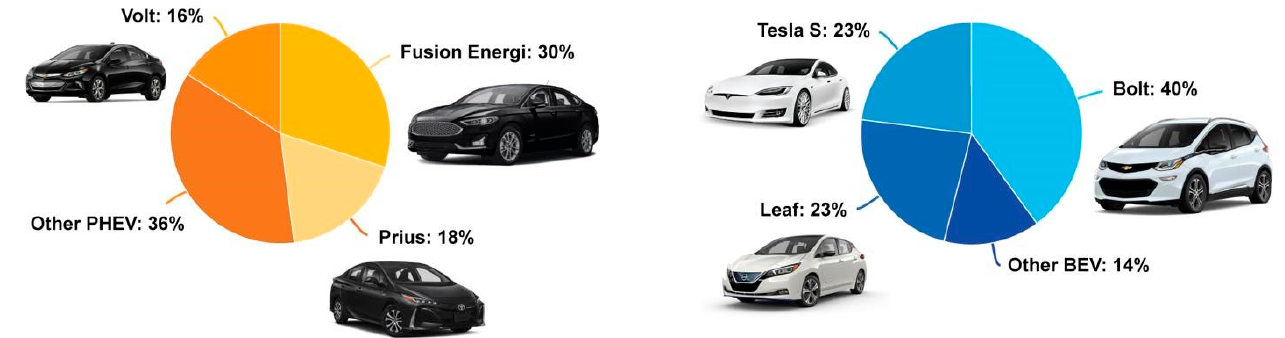
Figure 3. Most common PHEV and BEV models used by TNC drivers.